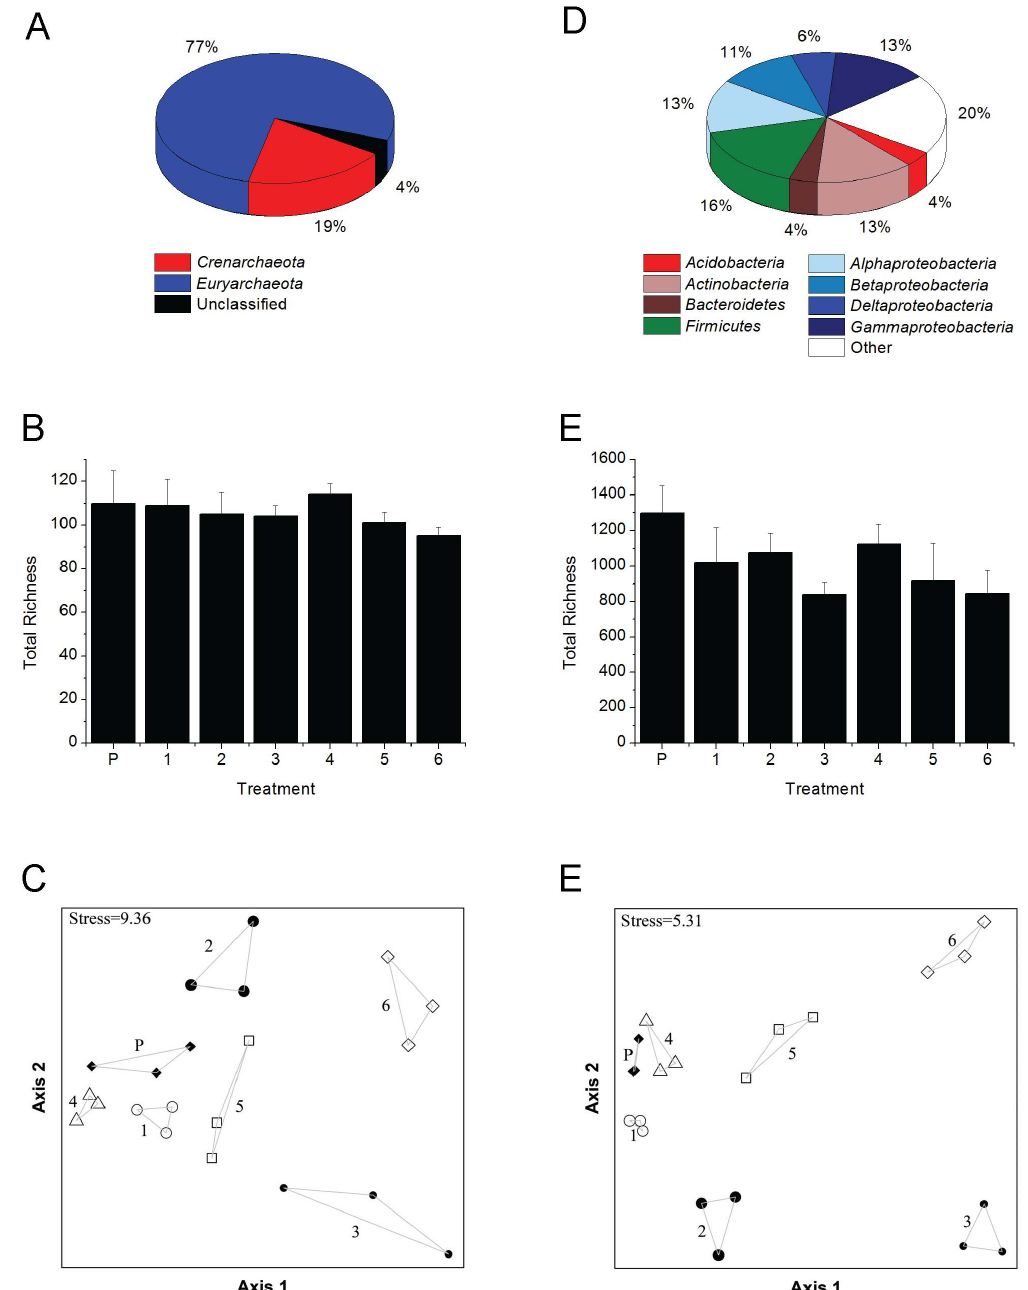
Figure 4. Archaeal and bacterial community structure. (A) Phylum-level richness of Archaea detected in sediments prior to treatments. (B) Archaeal richness detected in sediments pre- and post-treatments. (C) NMDS ordination of archaeal community distances present within replicate samples. (D) Phylum-level richness of Bacteria detected in sediments prior to treatments. (E) Bacterial richness detected in sediments pre- and post- treatments. (F) NMDS ordination of bacterial community distances present within replicate samples. Designations for all samples are as follows: P - sediments prior to treatment, 1 -pH 5.5 without organophosphate amendment, 2 -pH 5.5 amended with G2P, 3 -pH 5.5 amended with G3P, 4 -pH 6.8 without organophosphate amendment, 5 -pH 6.8 amended with G2P, and 6 -pH 6.8 amended with G3P. Phylum-level richness of Archaea and Bacteria prior to treatments represents the summation of total richness detected from replicate sediment DNA extractions. doi:10.1371/journal.pone.0100383.g004 Pseudomonadaceae were detected in three of the four organophos- Discussion phate-amended treatments with a 2-fold or greater increase in Within U-contaminated subsurface environments, in situ relative abundance. sequestration approaches that minimize contaminant transport under dynamic hydrogeological conditions (i.e., pH, O 2 , and co-